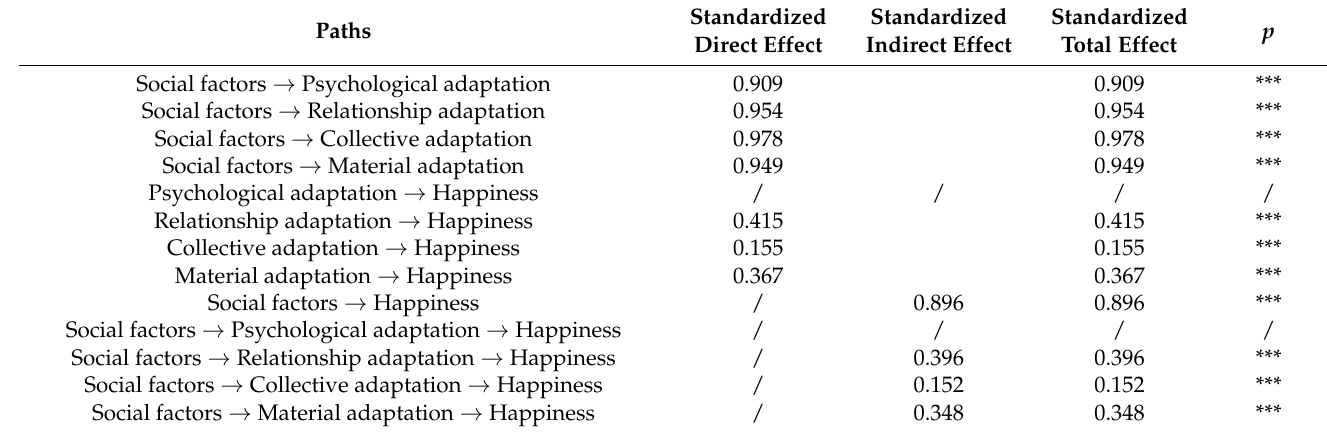
Table 8. The effects of social factors on the happiness of urban young returnees.